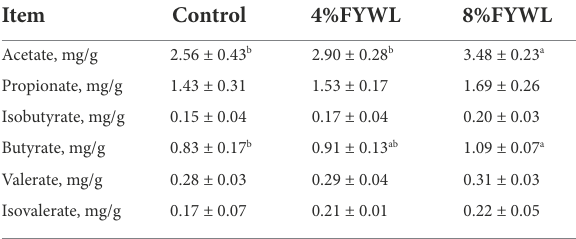
TABLE 4 Effect of FYWL on content of SCFA.